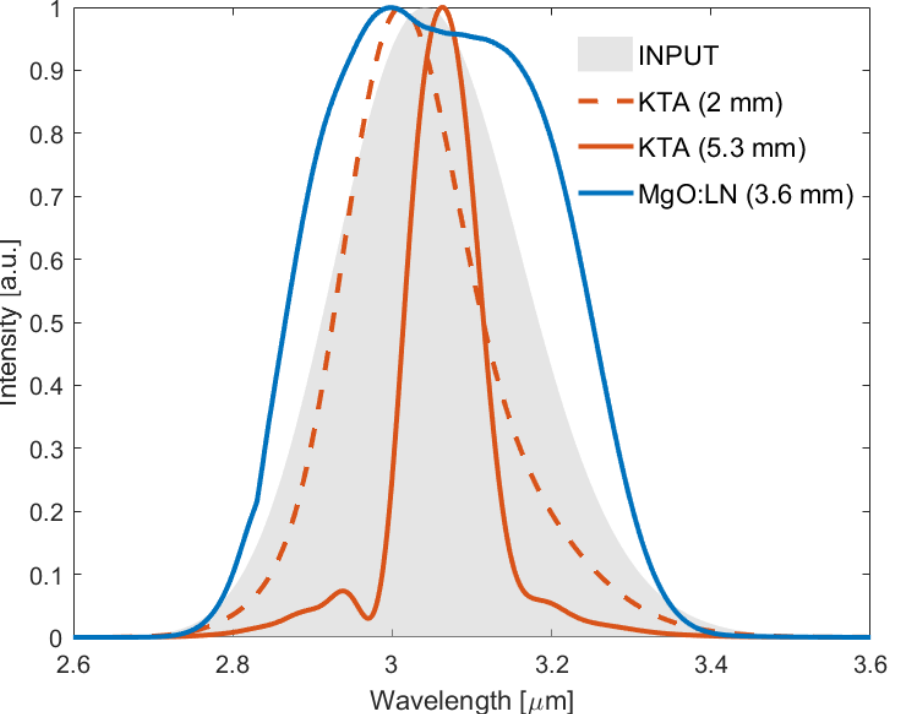
Figure 3. Output spectra for a 4 mJ pump. Input signal ( shaded curve ), 2 mm long KTA ( dashed red ), 5.3 mm long KTA ( red ), and 3.6 mm long MgO:LN ( blue